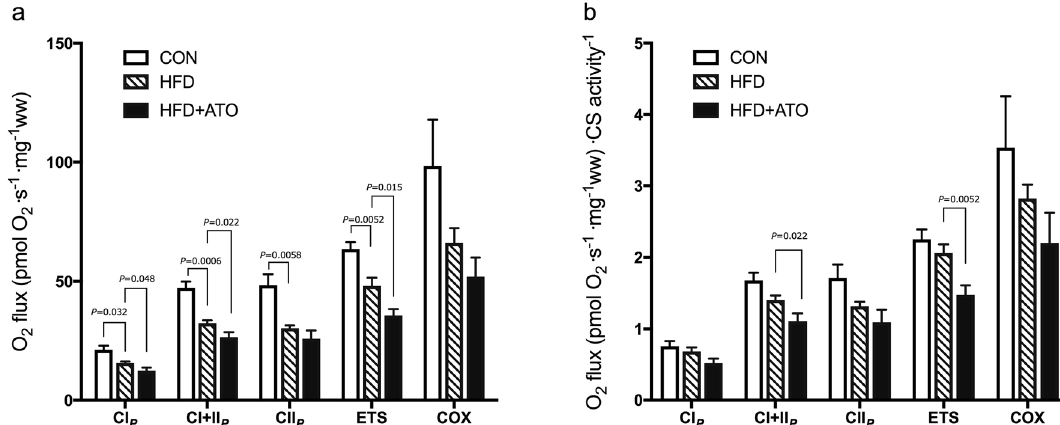
Figure 4. Effect of obesity and atorvastatin treatment on mitochondrial respiratory capacity in liver of Göttingen Minipigs. ( a) Maximal mitochondrial respiratory capacity expressed as respiratory flux per mg tissue with substrates and inhibitors stimulating electron flow through complex I (CI P : malate + glutamate), complex I + II (CI + II P : + succinate ) , complex II (CII P + rotenone), maximal uncoupled respiration (ETS + FCCP) and cytochrome c oxidase (COX: antimycin A + ascorbate + TMPD) activity in the liver of lean control minipigs (CON), obese minipigs (HFD) and obese minipigs treated with atorvastatin (HFD + ATO). The substrate and inhibitor titration protocols are described in detail in supplementary material. ( b ) Mitochondrial respiratory capacities shown in A in the liver normalized to CS activity. ETS electron transport system capacity, FCCP carbonyl cyanide p -(triflouromethoxy) phenylhydrazone, TMPD N , N , N ′ , N ′ -Tetramethyl- p -phenylediamine. Data are means ± SEM, n = 6–7 in each